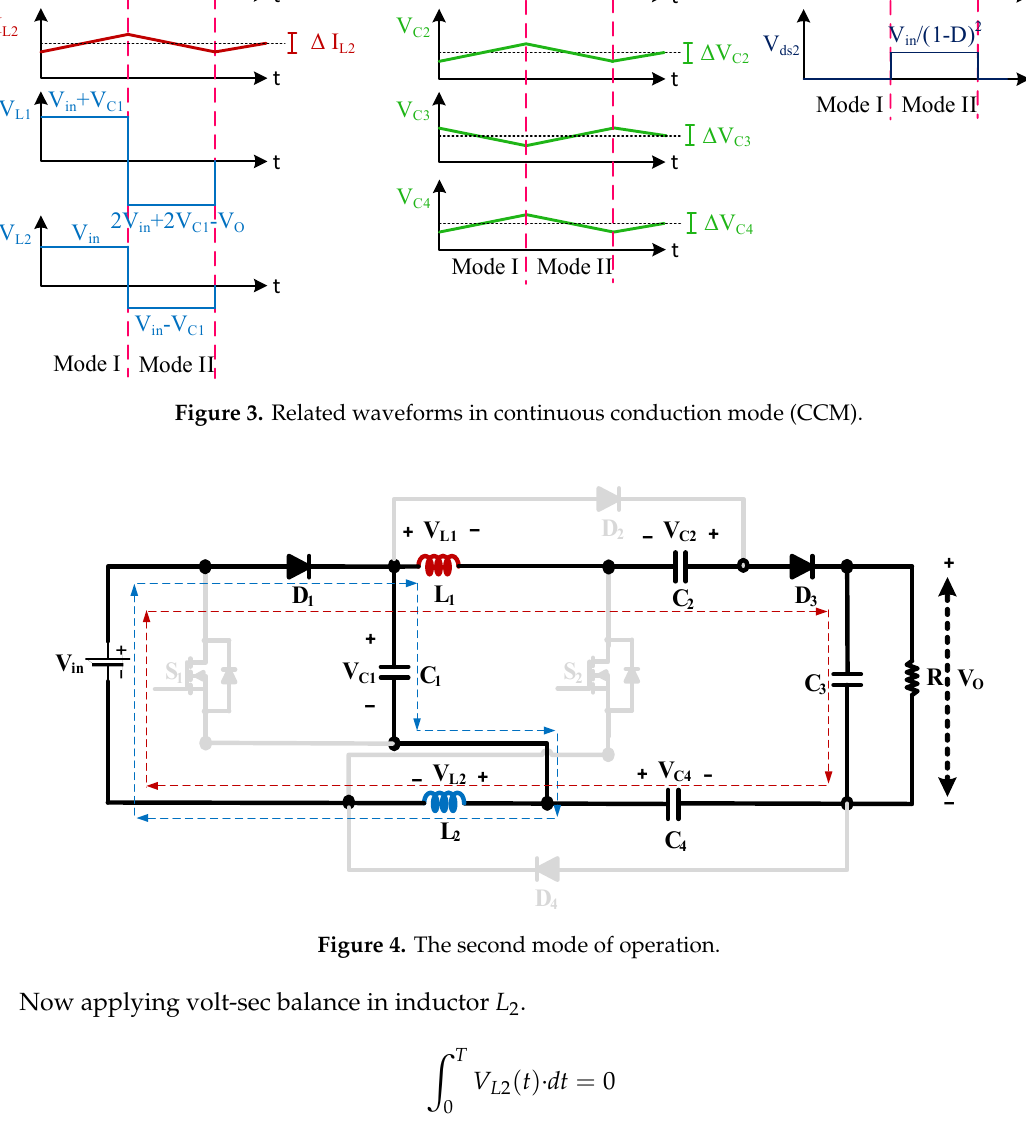
Figure 4. The second mode of operation.